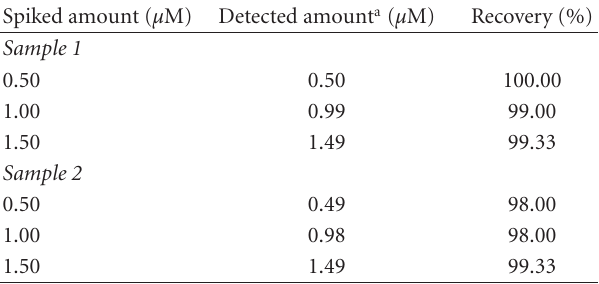
Table 2: Recovery data for salbutamol determination in plasma samples of healthy volunteers at SWNT-modified